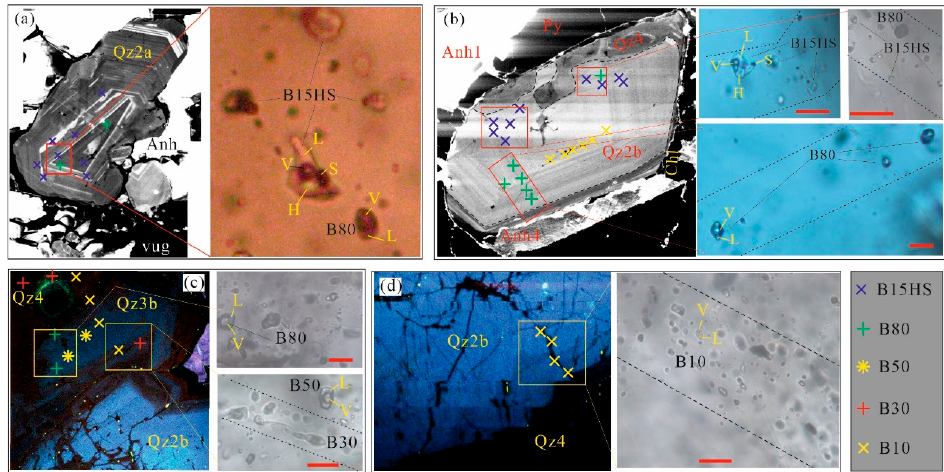
Figure 8. Petrography of fluid inclusions hosted in different generations of quartz in the Tongchang porphyry Cu deposit. The coexistence of brine (B15HS) and vapor-rich (B80) inclusions in Qz2a ( a ) and Qz2b ( b ), which distributed along CL growth zones indicative of primary origin; primary B50 inclusions in Qz3b with secondary trails of B80 and B30 inclusions ( c ); secondary trail of B10 inclusion in Qz2b ( d ). “B10” denotes the vapor phase and its volume proportion relative to the total inclusion volume; “L” denotes aqueous liquid, “V” denotes vapor, “H” denotes a halite daughter phase, and “S” denotes unidentified solids. CL growth zones are marked with dashed curves in the inclusion images. Scale bars are 10 µm.